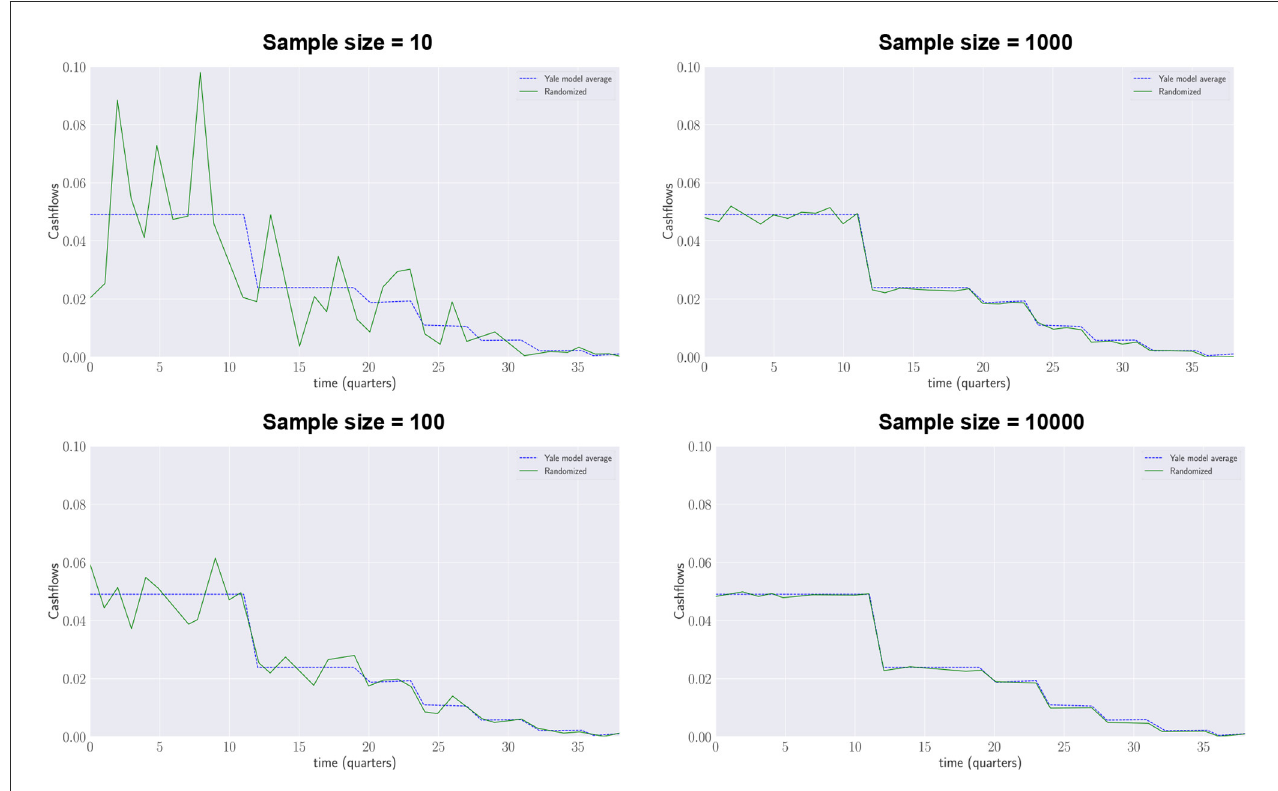
FIGURE4 Yale Plus model, quarterly drawdowns.